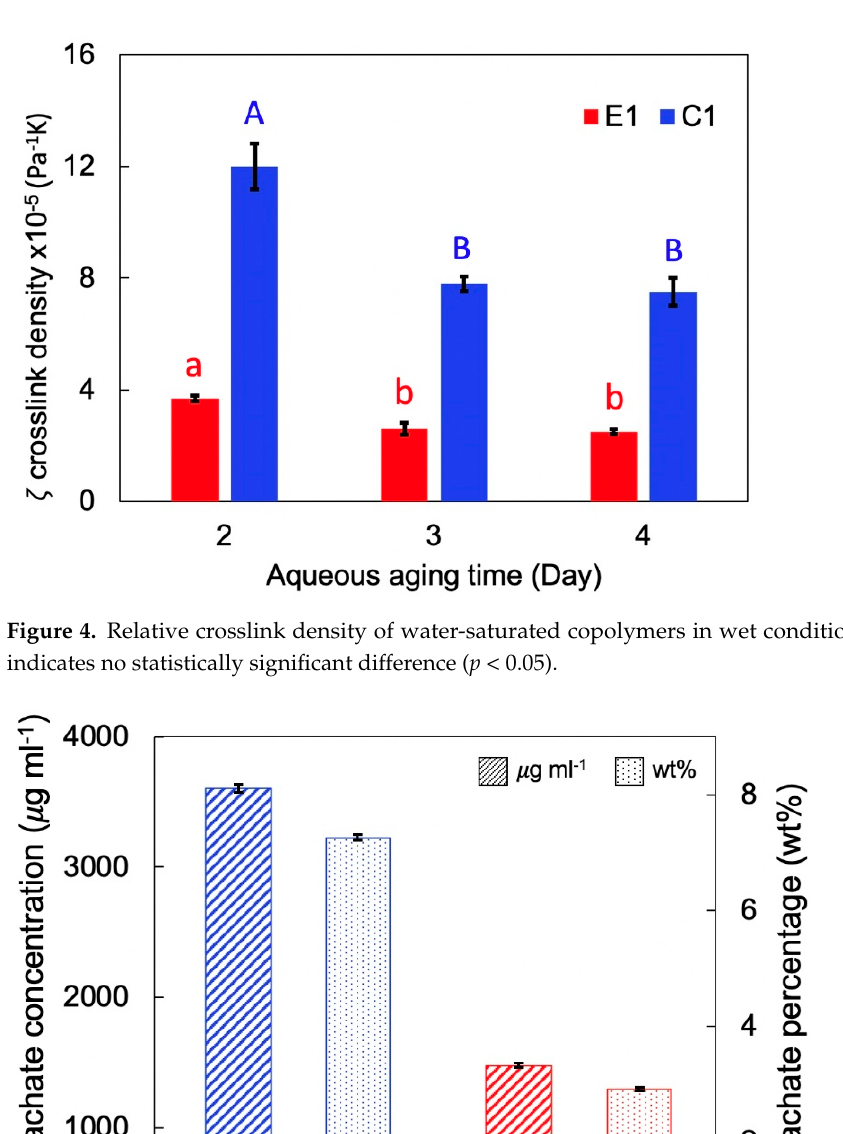
Figure 4. Relative crosslink density of water ‐ saturated copolymers in wet condition. Same letter indicates no statistically significant difference ( p < 0.05).